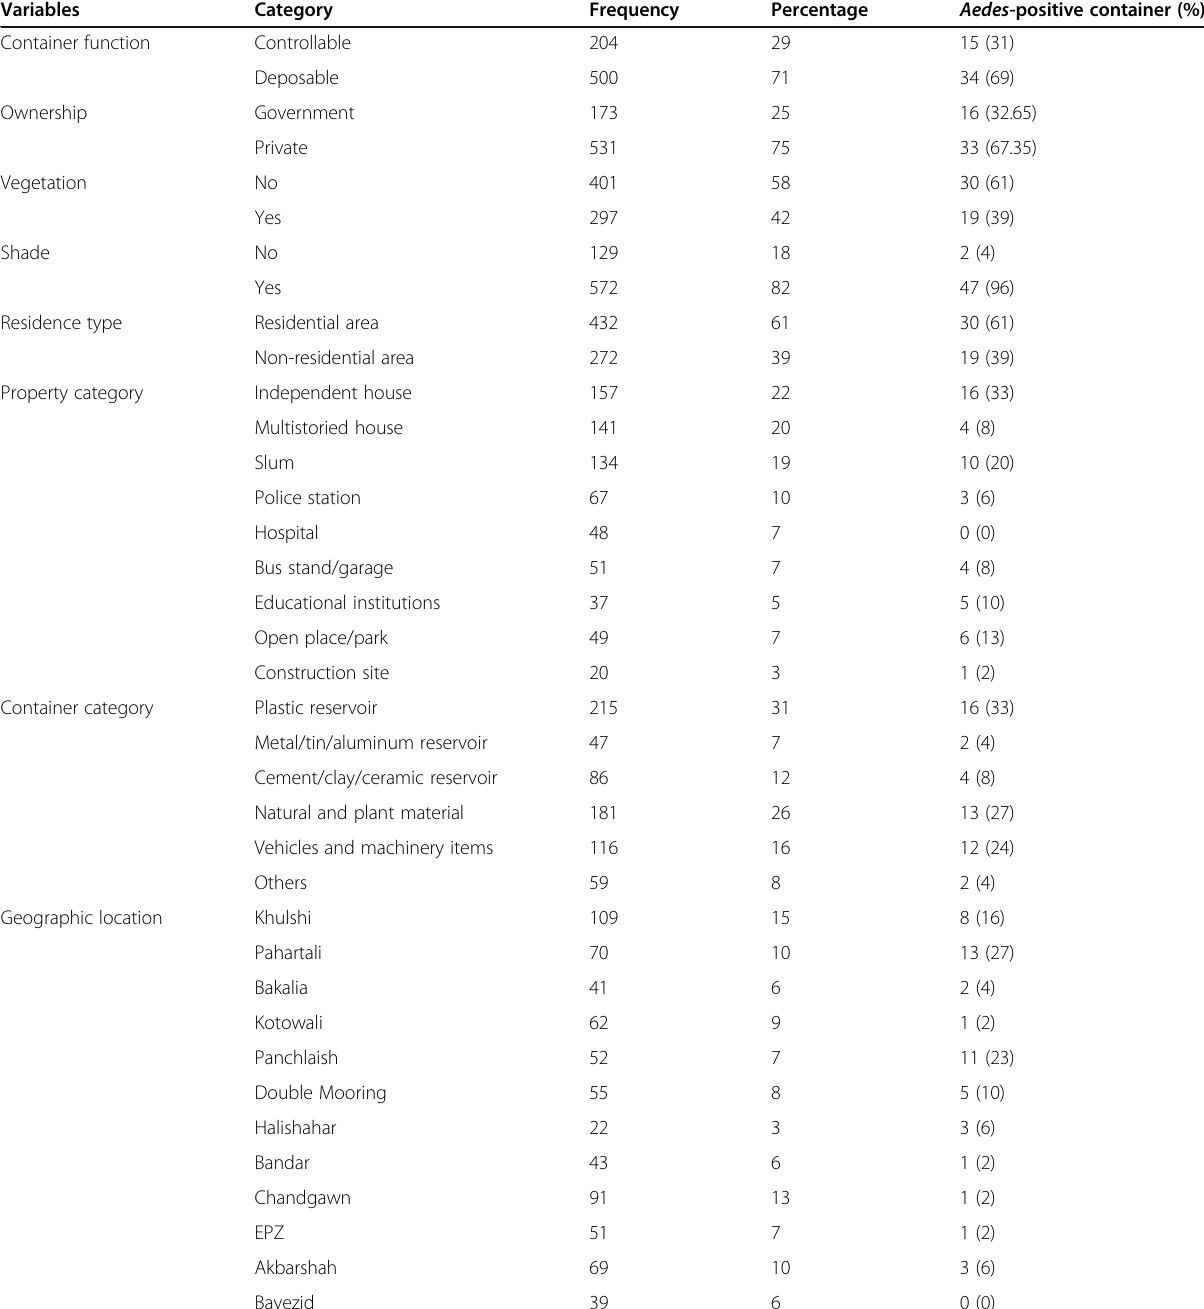
Table 2 General distribution of the background characteristics of wet containers in Chattogram, Bangladesh Variables